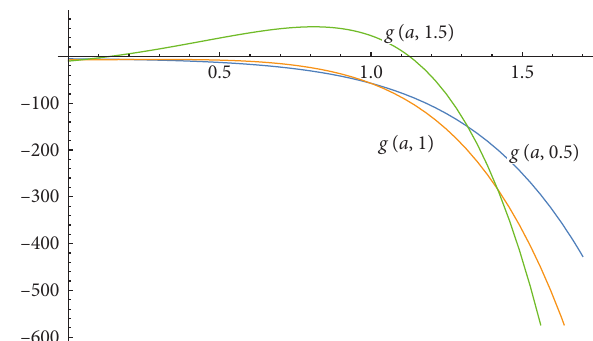
Figure 2: Graph of g ( a, b ) for values of b � 0 . 5 , 1 , and1 .